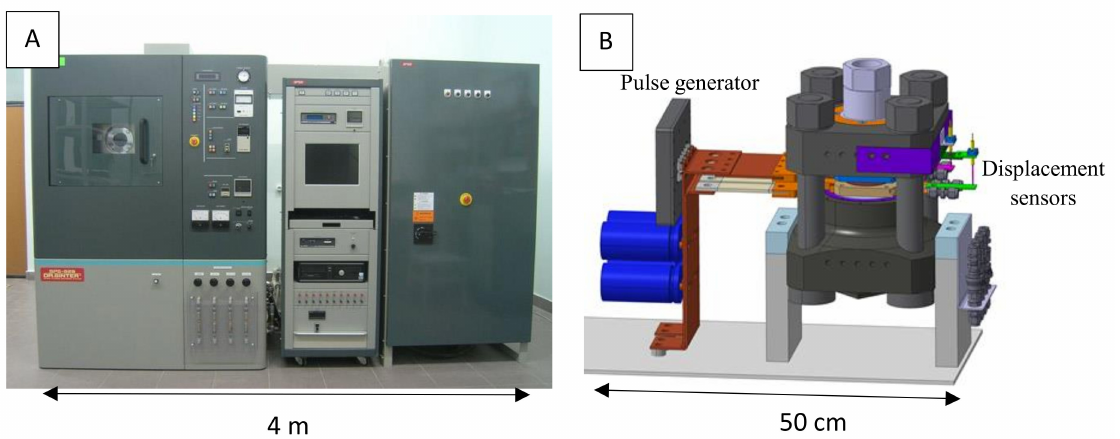
Figure 13. An SPS apparatus commercialized by FUJI Electronic Industrial Co., Ltd. (Tsurugashima, Japan) ( A ) and the tabletop HP-SPS device ( B